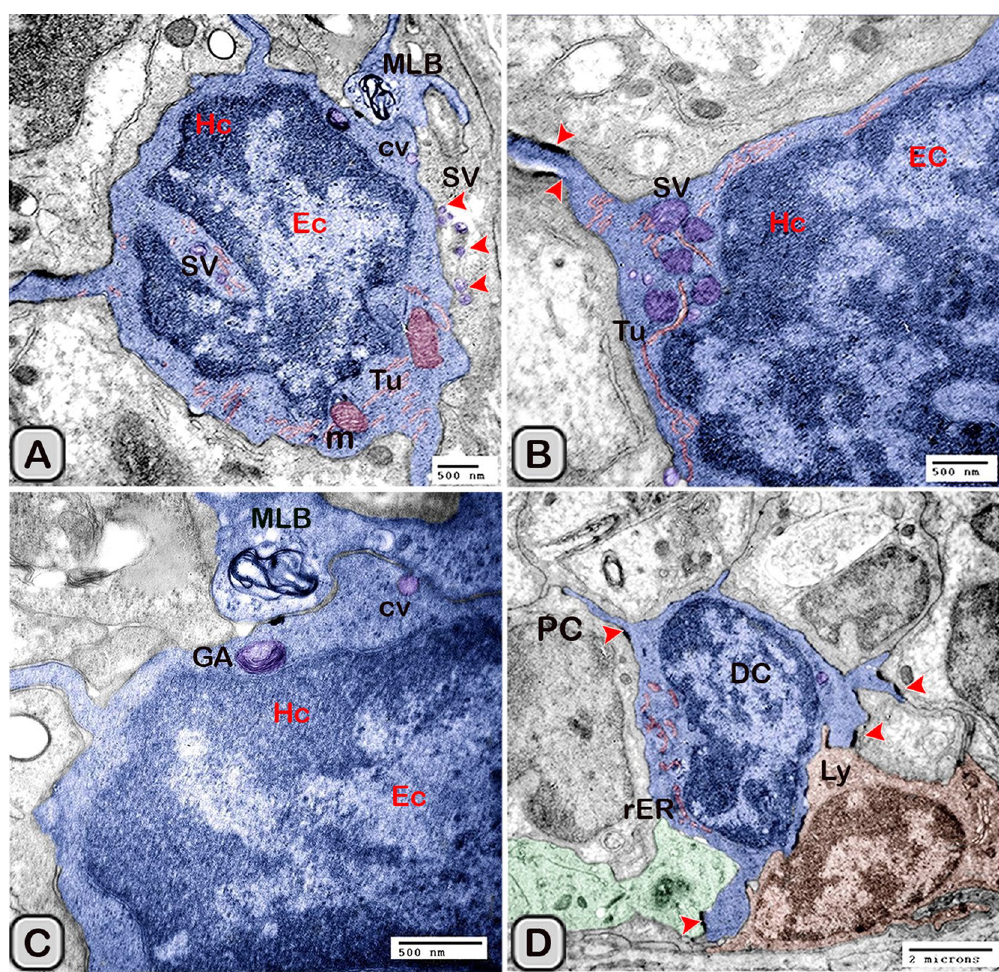
Figure 11. Digitally colored transmission electron microscope images of the DCs in the seminal vesicles of control groups. ( A–C ) The cytoplasm of the DCs (blue) contained relatively few cell organelles including the mitochondria (m), Golgi apparatus (GA), and short cisternae of the rER (arrowhead). The endosomal tubulo-vesicular system including the cavolae (cv), secretory vesicles (SV, red arrowhead) multilamellar bodies (MLB), numerous tubules (Tu) were observed. ( D ) The intercellular junctions such as the desmosomal junction (arrowheads) with the adjacent cells including T-lymphocytes (brown), principal cell (PC) lining the seminal vesicle and nerve fiber (green) were investigated. HC heterochromatin, EC